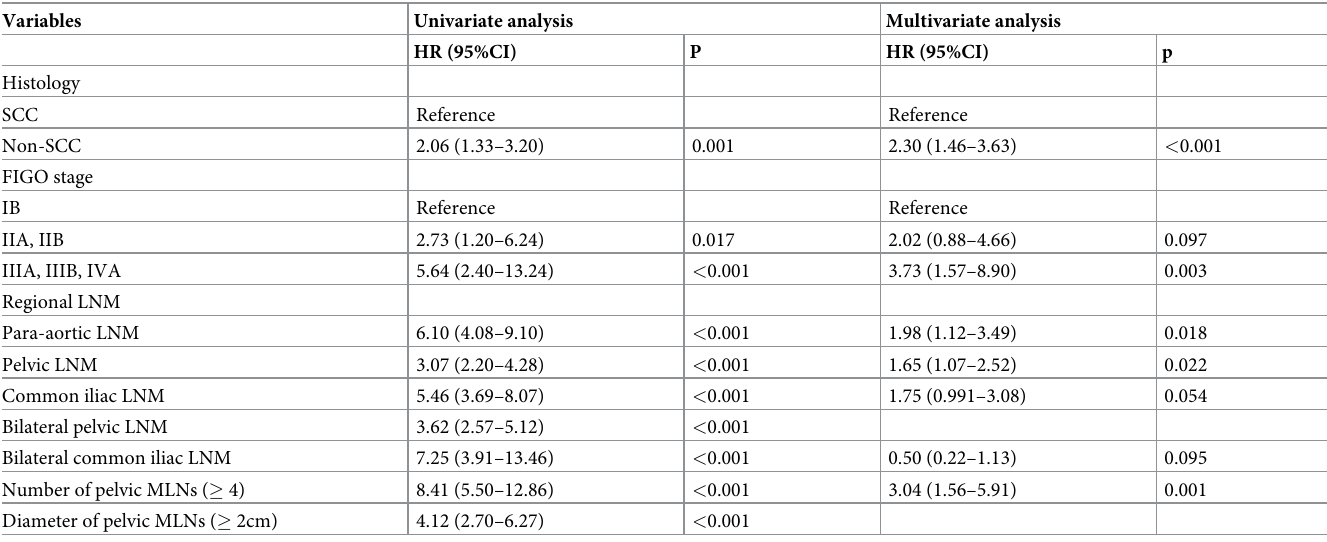
Table 2. Univariate and multivariate analysis for overall